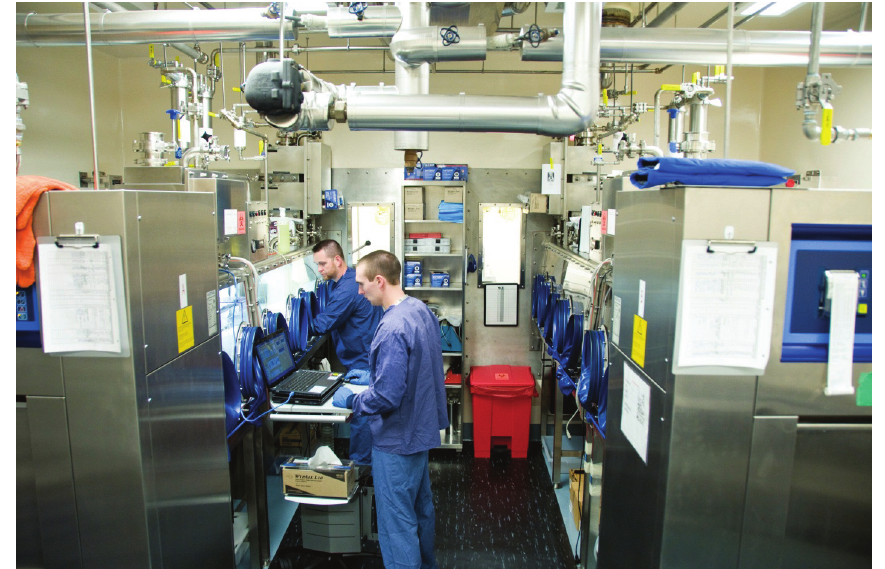
Figure 2. The IRF-Frederick Aerobiology Core Class III BSC laboratory. Shown are the IRF-Frederick Aerobiology Core’s two Class III BSCs within the ABSL-4 cabinet laboratory. One researcher is manipulating the contents of one of the Class III BSCs via synthetic rubber gloves. The other researcher is monitoring the parameters of the experiment electronically.